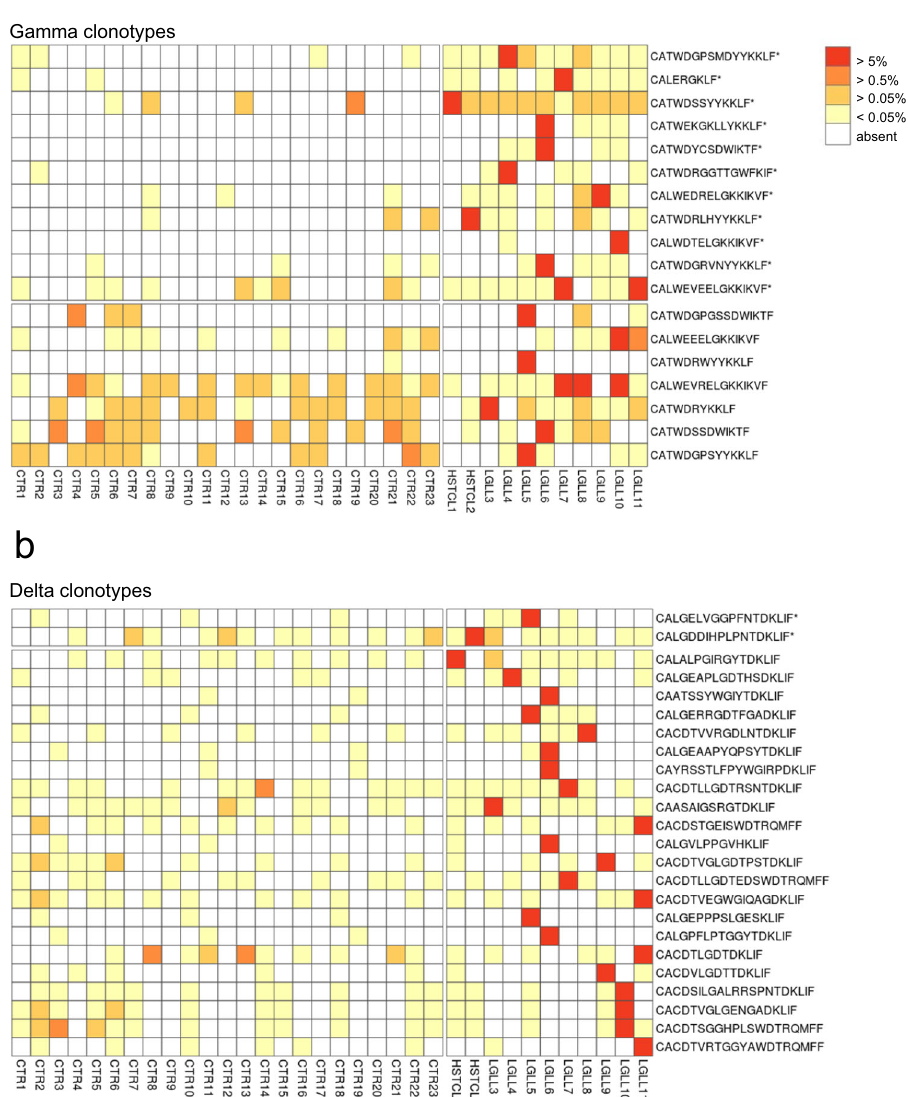
Fig. 2 Recurrence of gamma and delta chain major CDR3 sequences of γδ disease patients. Colored squares in the matrices indicate the presence of clonotype sequences in γ ( a ) and δ ( b ) TCR repertoires of the 11 T γδ neoplasia patients and the 23 healthy controls. The color represents the frequency in the sample. The fi rst 12 gamma clonotypes ( a ) and the fi rst 2 delta clonotypes ( b ) listed are signi fi cantly more frequent in patients than in controls (non- parametric Wilcoxon test, one-sided, * P < 0.05). Source data are provided as a Source data fi le. HSTCL: hepatosplenic T cell lymphoma, LGLL: large granular lymphocyte leukemia, CTR: